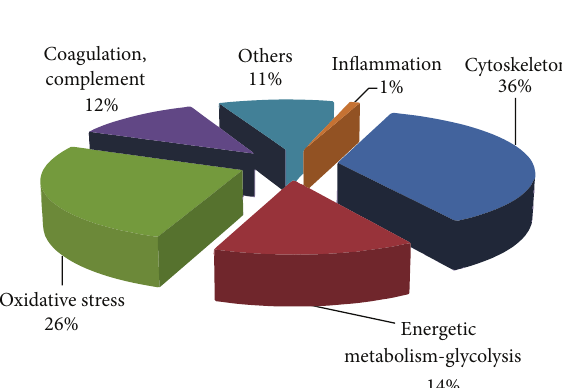
Figure 4: Pie charts of the 74 identified proteins. Proteins are divided on the basis of their functions based on Gene Ontology database (http://www.geneontology.org/).